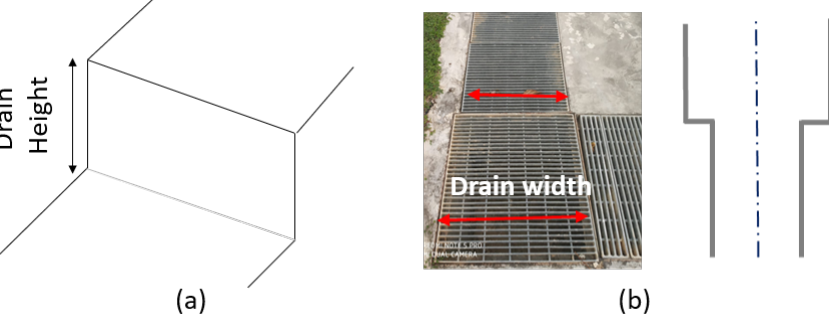
Figure 1. ( a ) Morphology of a drain with a level shift. ( b ) Drain width